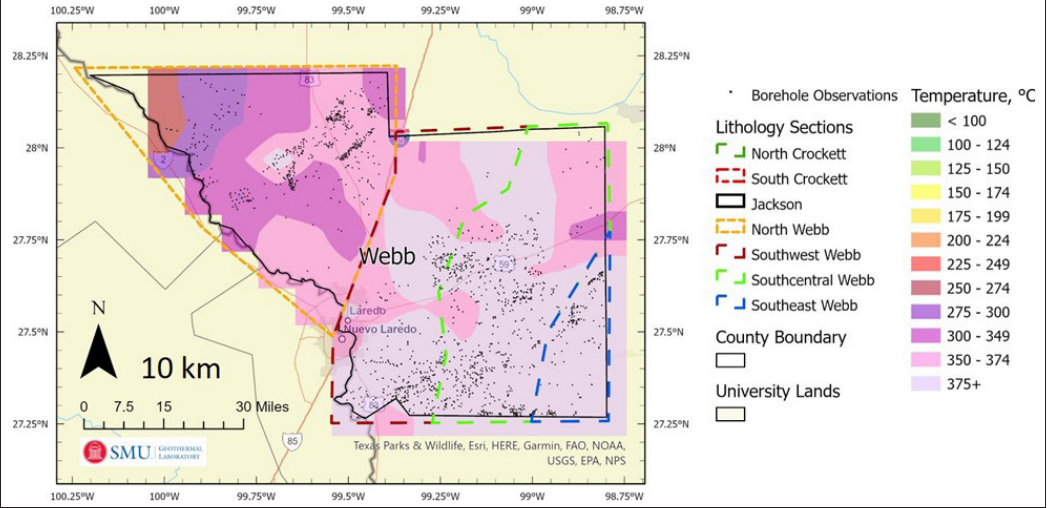
Figure 13. Modeled temperature at 10 kilometers (km; 32,800 feet) in Webb County. Surface well locations are displayed as black dots. At this depth, the temperature uncertainty is ±25%, which could be as high as ±100 °C (212 °F). The highest modeled temperatures (greater than 375 °C [700 °F]) continue to be in the southeastern portion of the county, which suggests there may be additional geothermal resources continuing to the south and east of Webb